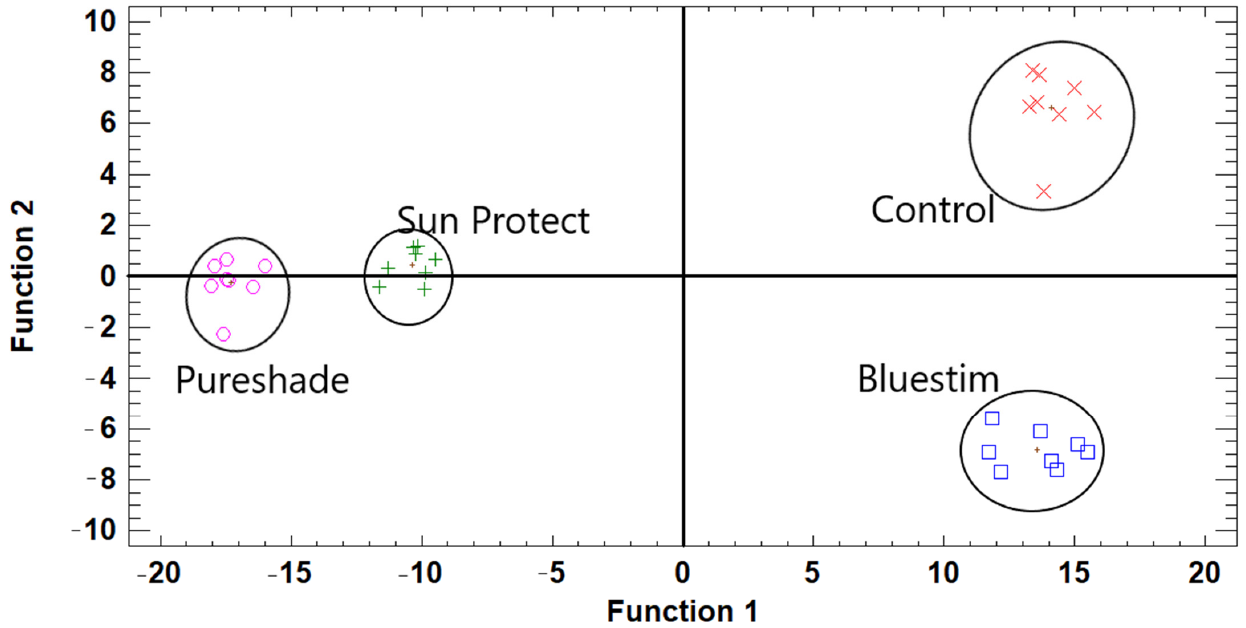
Figure 4. Plot of discriminant functions produced from the data of the first sampling on August 7th.